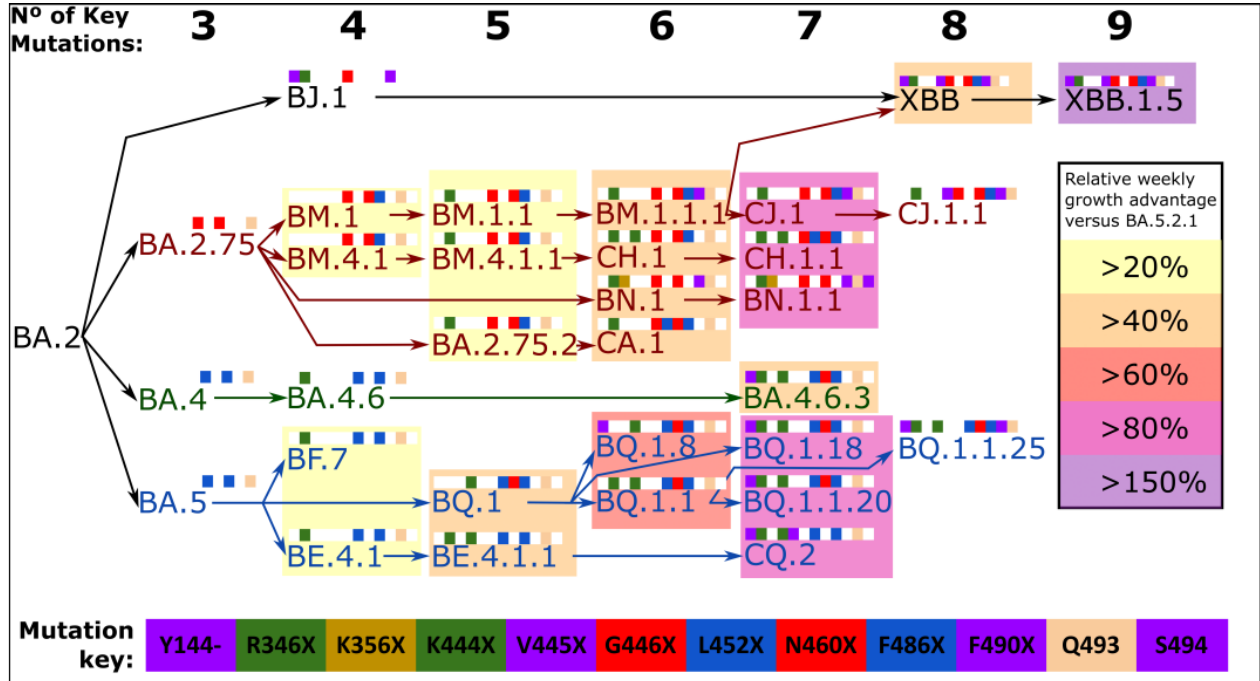
Figure 4. Step-wise accumulation of key Spike mutations involved in immune escape within SARS- CoV-2 Omicron sublineages increase the relative growth rate. Lineage name text is color coded, where BA.5 descendants are in blue text, BA.4 descendants in green text and BA.2.75 descendants are in red text. Each mutation is color coded as shown in the mutation key, and depicted as colored squares when present or white squares if absent. Number of key mutations of each lineage is sum- marized at the top. The F486P mutation is counted as two mutations due to the inherent increased fitness displayed by variants that carry this mutation relative to variants with F486S or F486V. Rel- ative growth rates were calculated using BA.5 lineage as baseline, for groups of BA.4, BA.5, BA.2.75 and XBB descendant lineages with each exact total number of key mutations. Relative growth rates were calculated using global data, using CoV-Spectrum [30]. as of 26 December 2022.